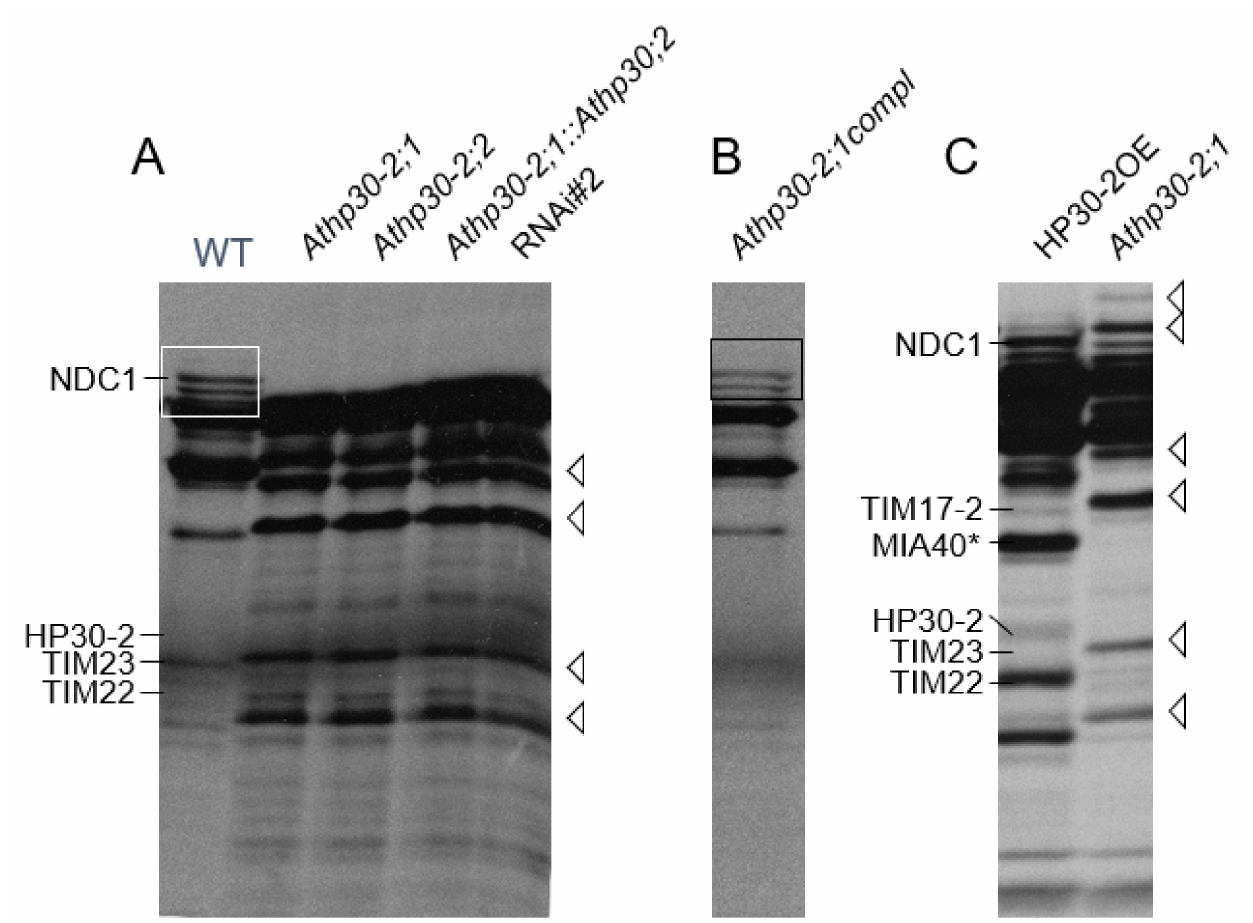
Figure 3. Analysis of inner mitochondrial membrane proteins in Athp30-2 and Athp30 mutant plants. ( A ) Pattern of inner mitochondrial membrane proteins in wild-type (WT) plants, Athp30-2;1 (SALK_136524) and Athp30-2;2 (SALK_136525) single mutant plants, Athp30-2;2 (SALK_136525):: Athp30;2 (SALK_112126) double mutant plants, and RNAi plants lacking both HP30 and HP30-2 ( RNAi#2 ; cf. Rossig et al., 2013 and 2017). ( B ) Pattern of inner mitochondrial membrane proteins in Athp30-2;1 (SALK_136524) plants that had been genetically complemented with the HP30-2 cDNA ( Athp30-2;1compl) . ( C ) Pattern of inner mitochondrial membrane proteins in wild-type plants overexpressing the HP30-2 cDNA, as compared to Athp30-2;1 (SALK_136524) mutant plants. NDC1 defines the C subunit of the alternative NAD(P)H dehydrogenase, MIA40 defines the 40 kDa mitochondrial intermembrane space import and assembly protein, and TIM17-2, TIM22 and TIM23 define key translocase components operative in the import of cytosolic precursor proteins into and across the inner mitochondrial